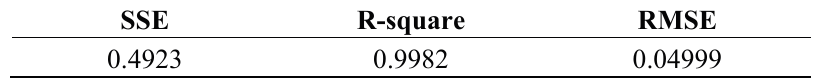
Table 4. Curve fitting accuracy of the first transient model curve